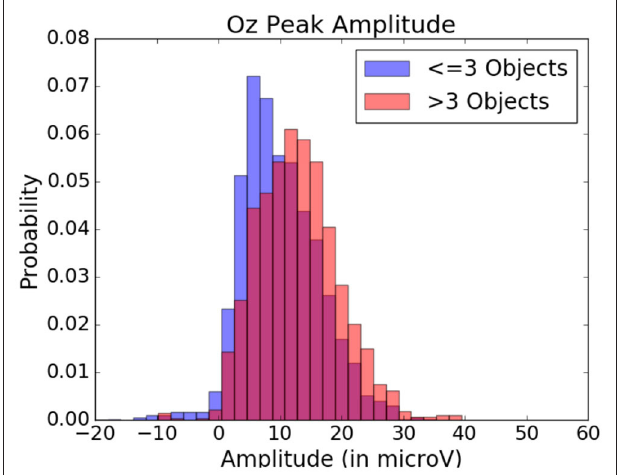
FIGURE 12 | Relative fixation duration depending on the present or absence of keyboard presses, expressed in probability. Data from one participant was used in this